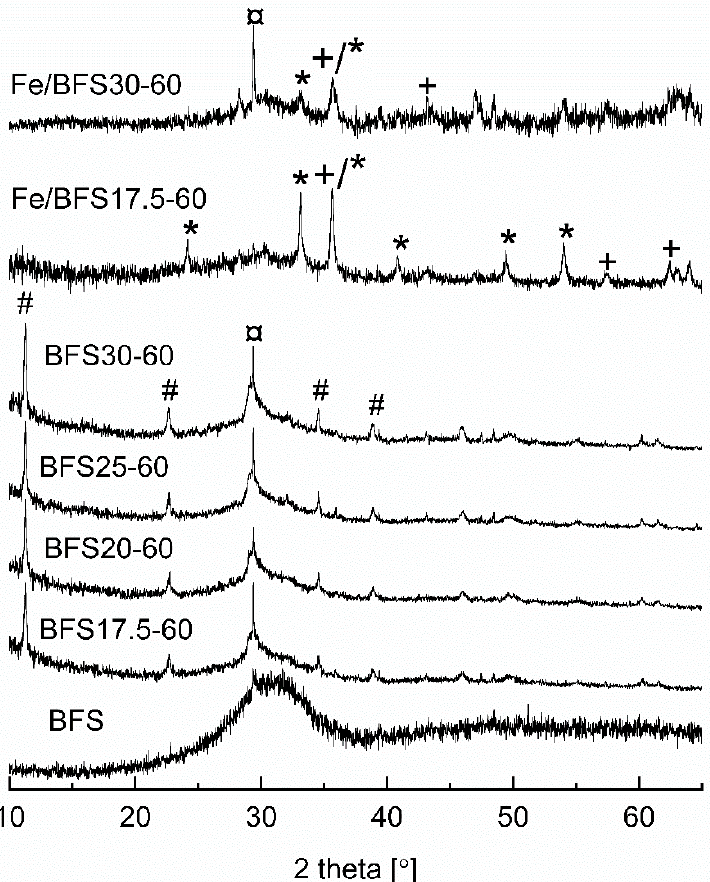
Figure 1. X-ray diffractograms of BFS raw material, supports, and Fe catalysts. (#) ICDD file 00- 022-0700 (Mg 6 Al 2 CO 3 (OH) 16 ·4H 2 O, hydrotalcite); (¤) ICDD file 01-083-4609 (CaCO 3 ); (*) ICDD file 04-015-7029 (Fe 2 O 3 ); (+) ICDD file 04-008-8146 (Fe 3 O 4 ).